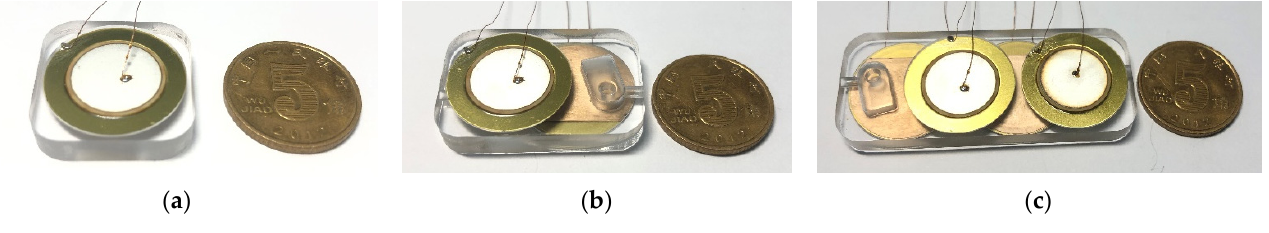
Figure 4. Photos of the piezoelectric micropump prototype. ( a ) Single-chamber. ( b ) Double-cham- ber. ( c ) Four-chamber.